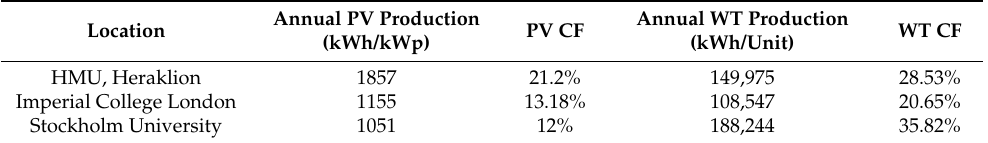
Table 10. Comparison of PV and WT annual electricity production for three different locations of university